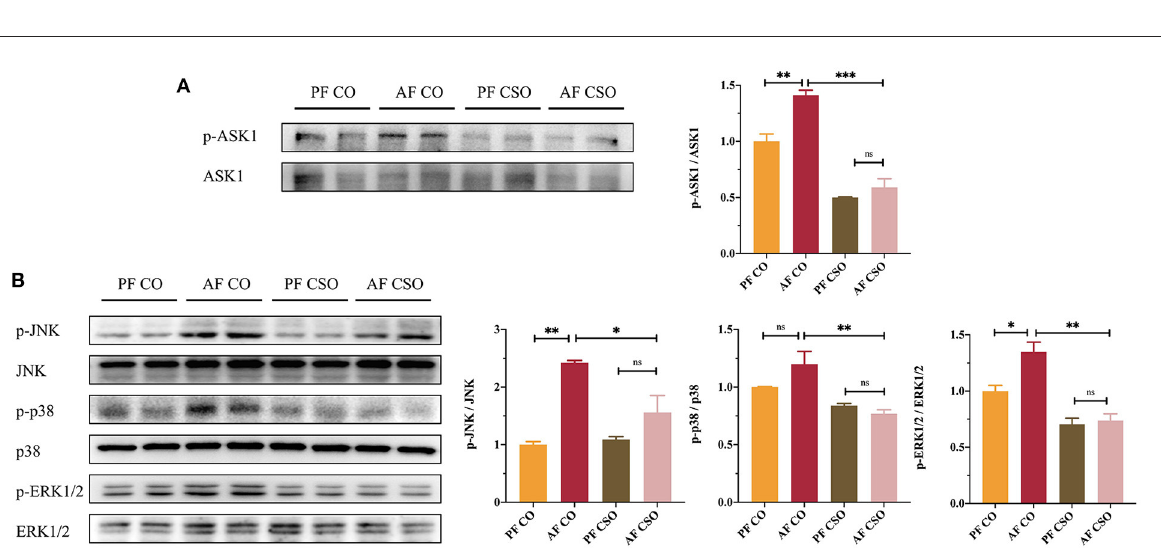
FIGURE4 ASK1/MAPKs signaling pathways are involved in CSO-protected liver injury. (A) The expression of hepatic p-ASK1/ASK1. (B) The expression of hepatic p-JNK/JNK, p-p38/p38, and p-ERK1/2/ERK1/2. * P < 0.05, ** P < 0.01, and *** P < 0.001 indicate statistically